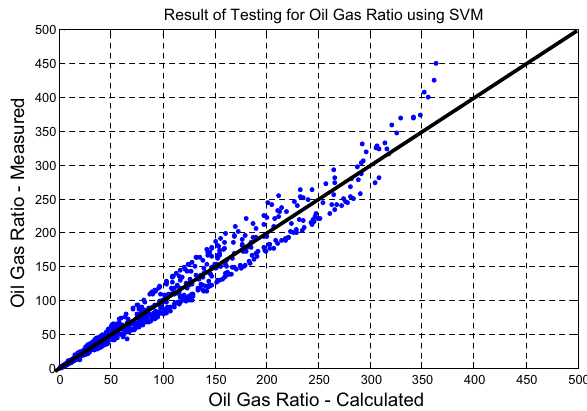
v using FN for testing